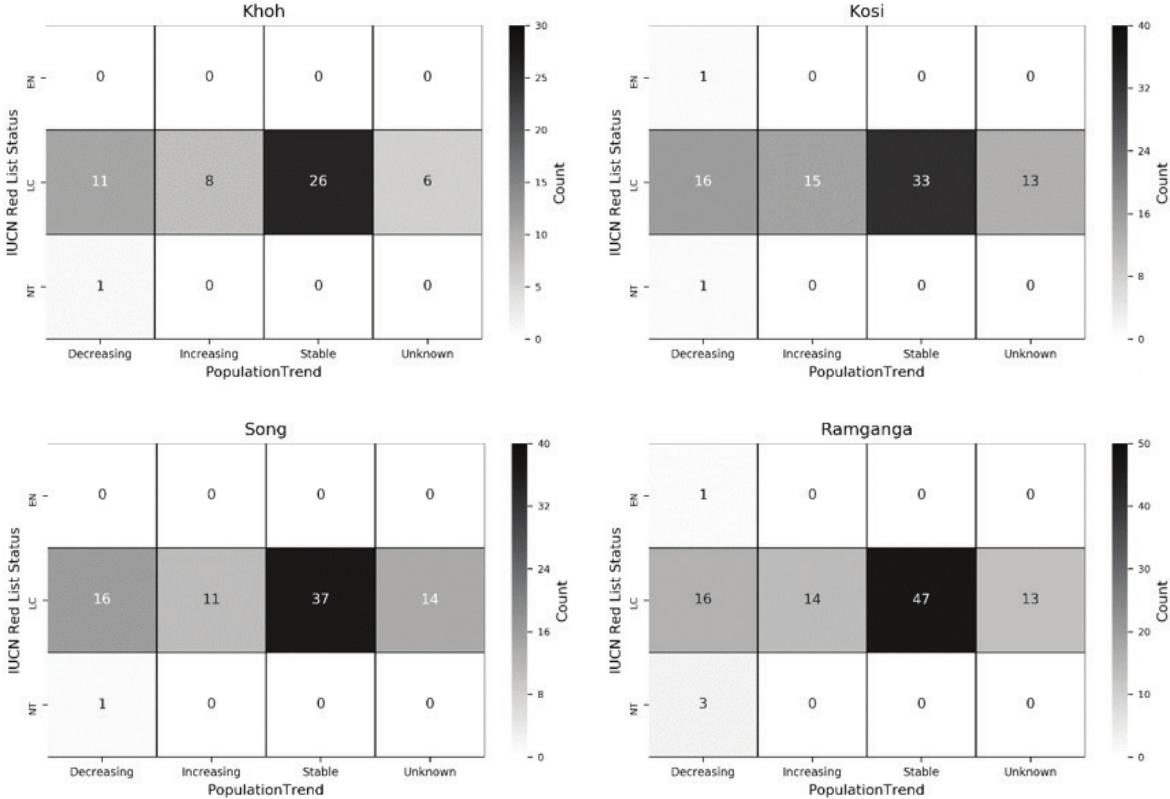
Figure 3. Avian species recorded from the individual rivers (the x-axis represents the population trend, the y-axis the IUCN Red List Status, and the bars provide the IUCN Red List Status and their corresponding population trend). The unit here is the number of species rather than count of